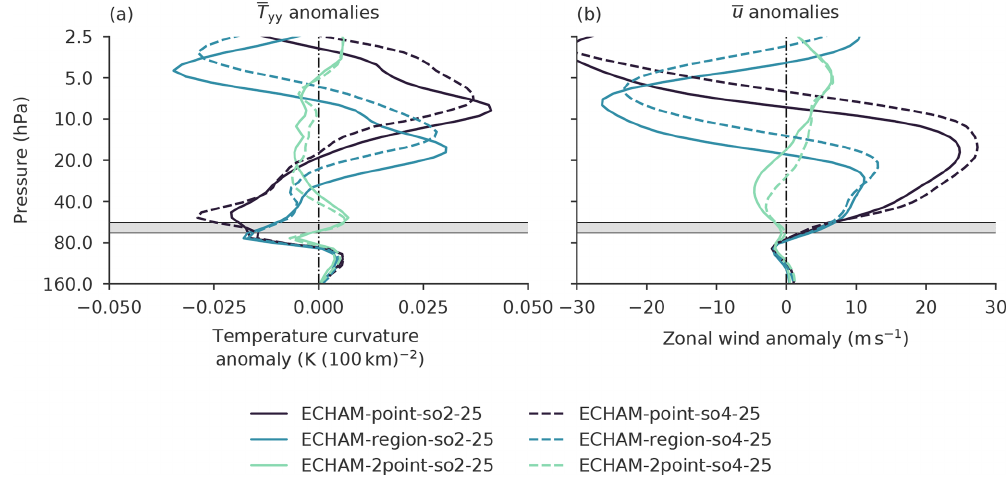
Figure 9. Vertical profile of the 5 ◦ N to 5 ◦ S mean anomaly of the temperature curvature T yy (a) and the tropical mean anomaly of the zonal wind u (b) for the ECHAM simulations of injections with an injection rate of 25Tg ( S ) yr − 1 . The horizontal grey bar marks the injection layer. The vertical dashed–dotted line marks an anomaly of 0K ( 100km ) − 2 (a) and 0ms − 1 (b) .